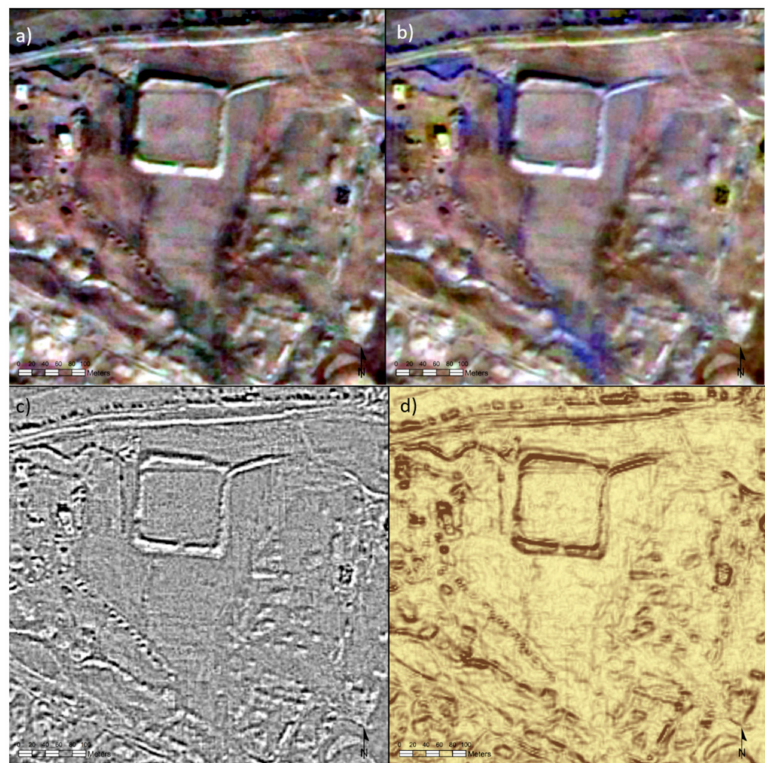
Figure 5. The application of the filter visualization algorithms. Figures show: ( a ) The original image; ( b ) synthesis of 1, 2, and 4 FORMOSAT-2 bands (RGNIR); ( c ) the results of applying the High Pass filter; and ( d ) those of applying the Sobel filter (author: Lenka Starkov á